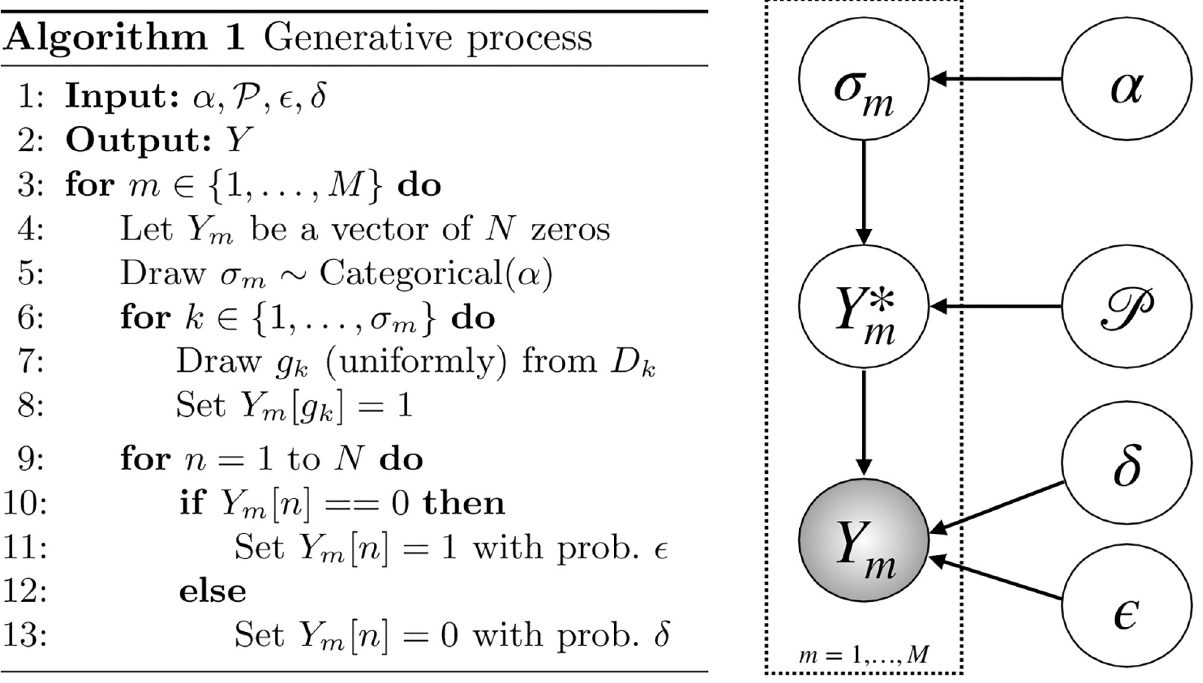
Fig 2. Generative process and the underlying graphical model for the observed mutation